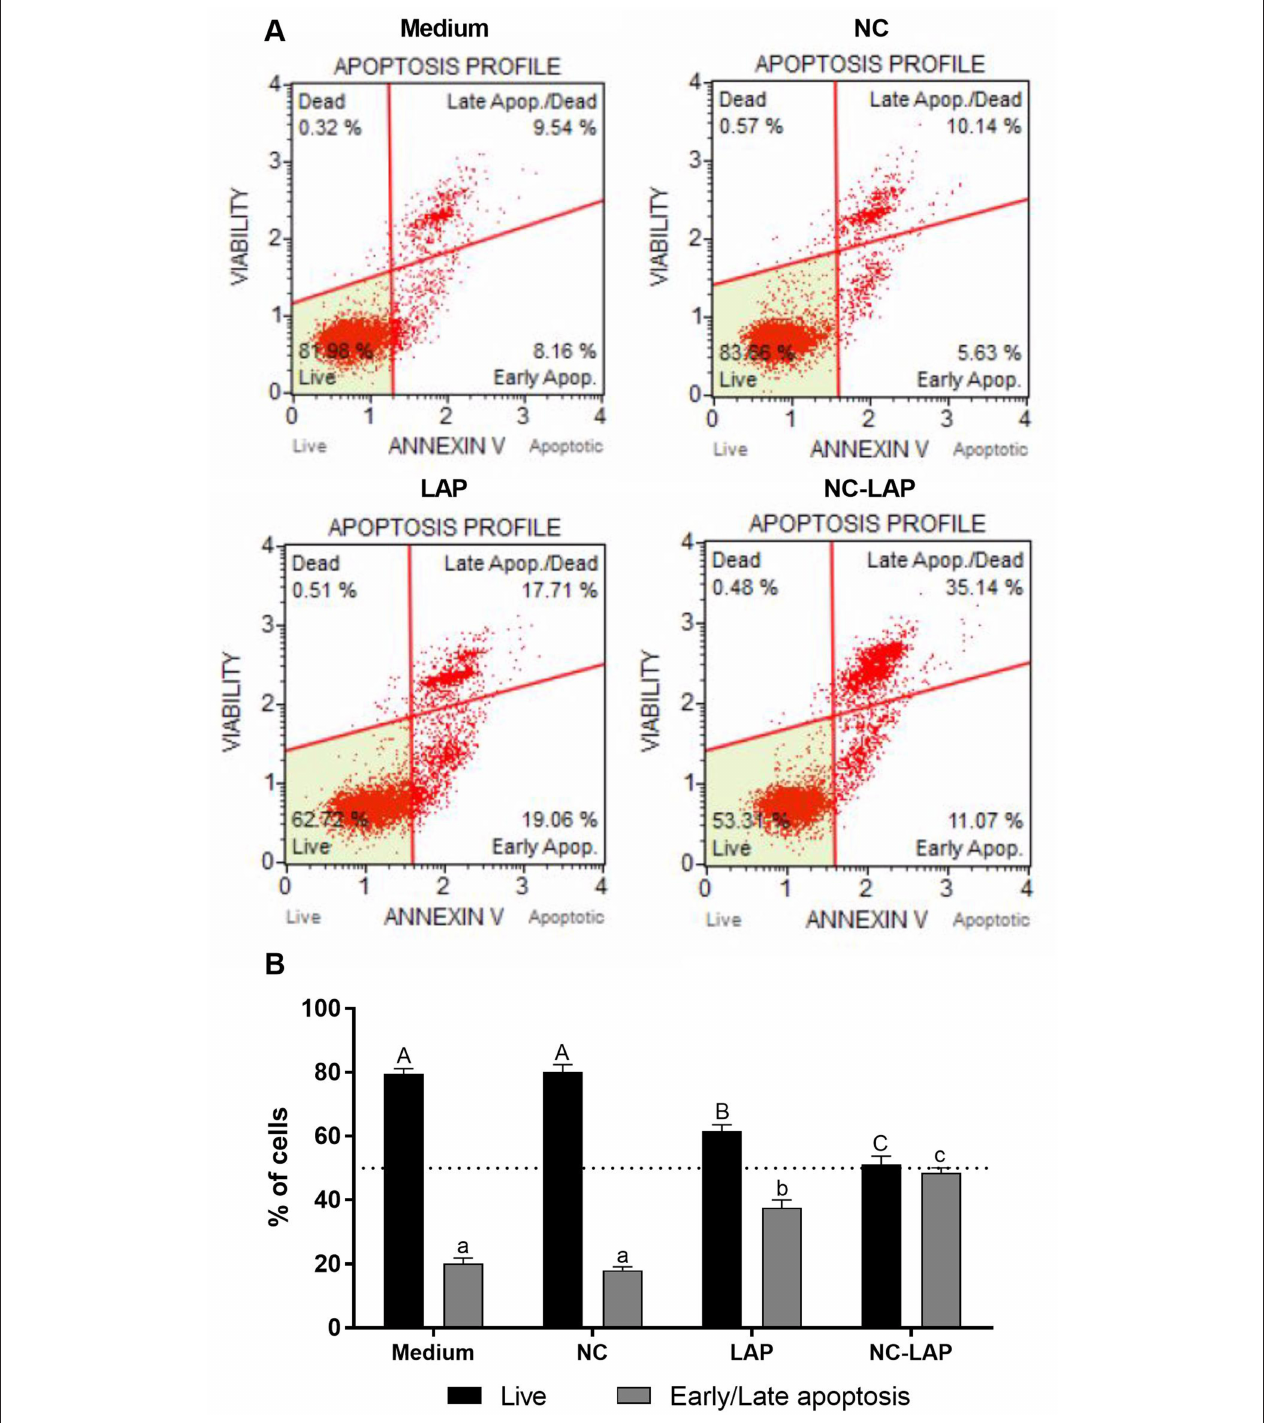
FIGURE 3 | NC-LAP treatment induces apoptosis in T24 cells. T24 cells were incubated with medium (control), LAP or NC-LAP at 5 µ M, as well as the relative amount of NC for 48h. (A) Dot Plot shows the percentage of cell live or early/late apoptosis after each treatment determined by Muse ® Annexin V and Dead Cell Assay. Dot Plot Upper: Medium (left side) and NC (right side). Dot Plot Bottom: LAP (left side) and NC-LAP (right side). (B) The graphic represents the expressed data by mean ± SEM with data from three independent experiments. The one-way ANOVA with Tukey post-hoc was used to determine statistical significance. Different capital letters indicate significant differences between means of live cells as well different lowercase letters indicate significant differences between means of cells in early/late apoptosis. Significance was considered at P < 0.05.